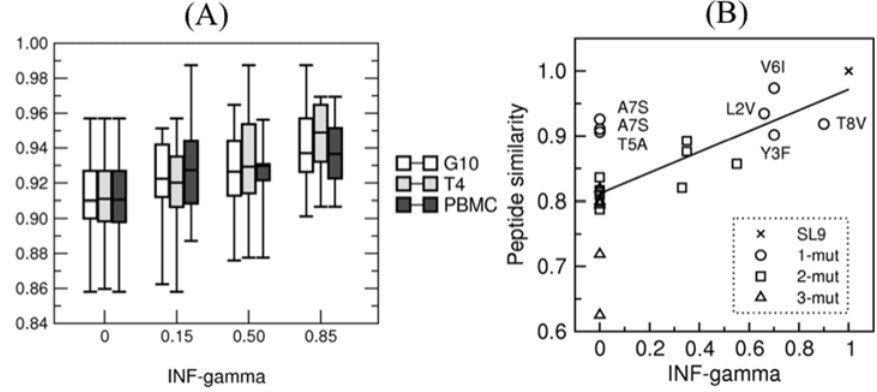
Figure 2. Predicting cross-reactivity. (A) Box plot of ELISPOT data for the two CTL clones G10 and T4, and PBMC. The x-axis shows the relative IFN c secretion measured for 171 single mutants of SLFNTVATL (SFL9). Immunogenicity was grouped in four bins with average ELISPOT responses of 0, 0.15, 0.50 and 0.85 of maximal ELISPOT for SFL9. In both figures the y-axis shows the predicted CTL recognition in terms of BLOSUM35 similarity scores (see Eq. 2). Unfavorable (non-conservative) substitutions (low x) are associated with a low similarity score (low y) whereas conservative substitutions (high x) in general are associated with higher similarity scores (high y). (B) Observed and predicted recognition of patient derived SLYNTVATL (SYL9) variants with 0–3 mutations. The axis shows the relative IFN c and peptide similarity scores. Note, that the IFN c response falls to a half when peptide similarity is around 0.85.